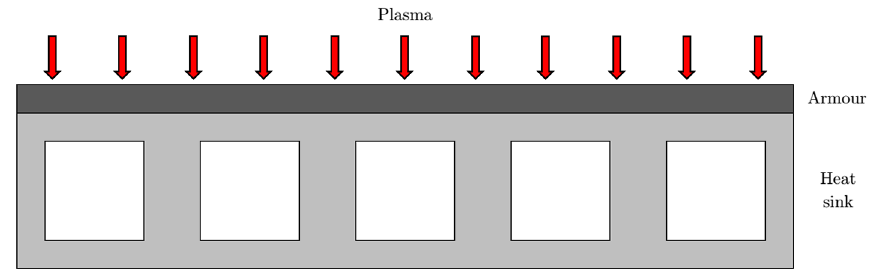
Fig. 1. – Cartoon schematic illustrating a possible layout of an actively cooled first wall compo- nent, with multiple rectangular cooling channels in the heat sink and a flat tile